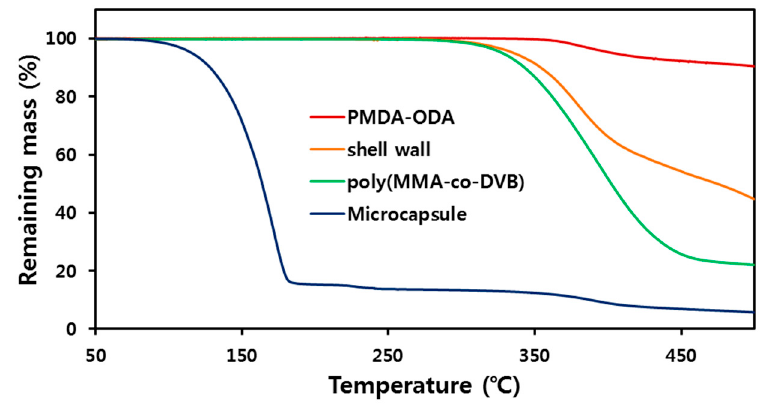
Figure 11. TGA thermograms of PMDA-ODA, the shell wall, poly(MMA- co -DVB), and the microcapsule. The shell wall sample was obtained by pressing the microcapsules between two slide glasses and drying.